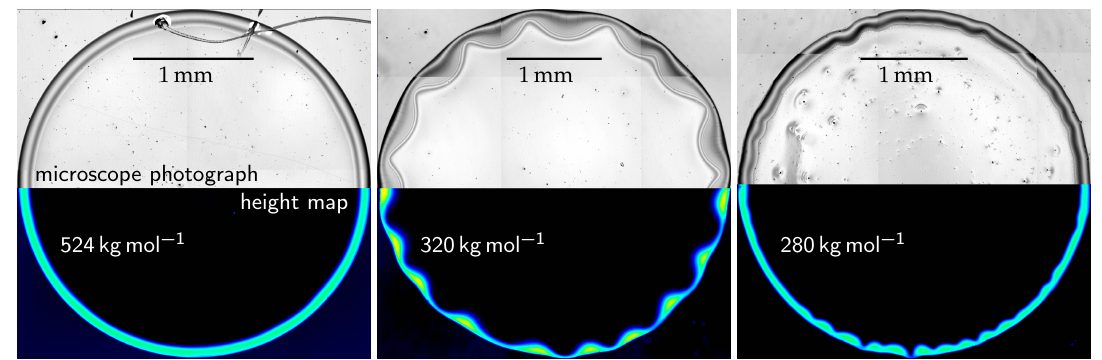
Figure 8. Surface appearance after evaporation of solvent droplets on different substrates. The top half of each image displays microscope photographs. The bottom half displays height maps. Both representations are recorded simultaneously using a confocal